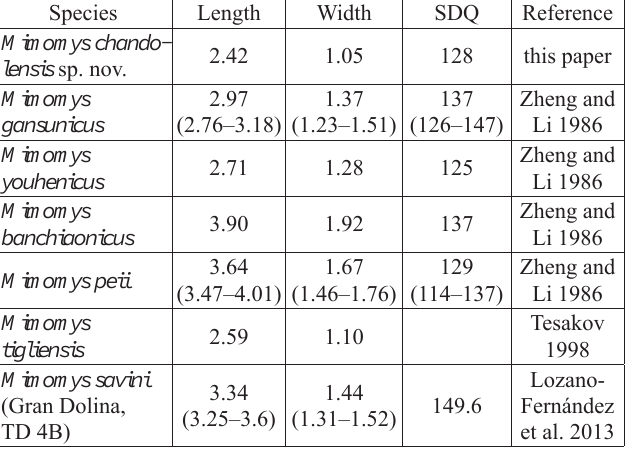
Table 1. The basic measurements: mean value and range (in mm) of m1 of Mimomys chandolensis sp. nov. from Medvezhyi Klyk cave, being compared to some other species of Mimomys . SDQ, enamel differentiation